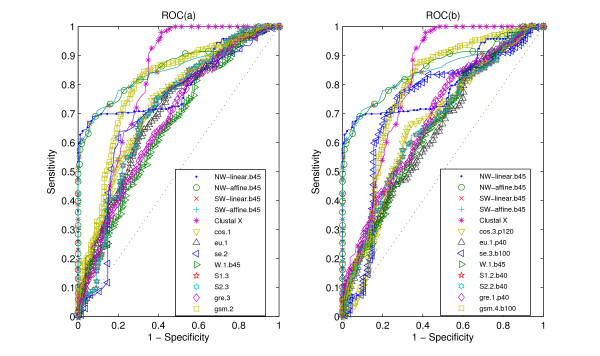
ROC curves for data CK. ROC (a) for our measures, alignment-based measures and other statistical measures, all the statistical measures are based on k-word frequencies of protein sequence, with the parameter values as suffix. ROC (b) for our measures, alignment-based measures and other statistical measures, all the statistical measures are based on k-word frequencies of protein 'sequence space', with the parameter values as suffix. All the abbreviations of (dis)similarity measures are illustrated in the "List of abbreviations" section. A random classifier would generate equal proportions of FP and TP classifications, which corresponds to the ROC diagonal (dashed line).